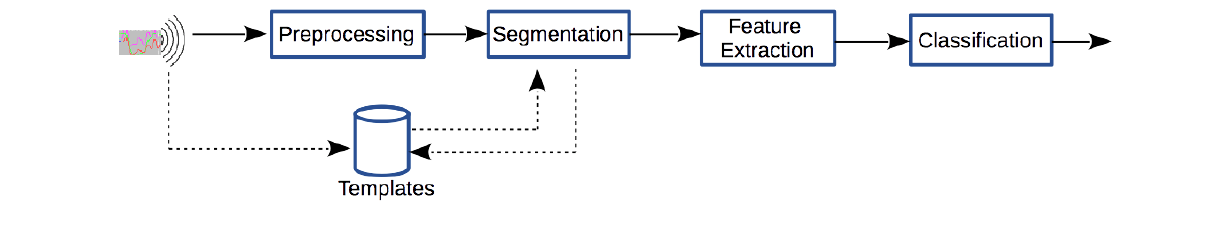
Figure 1. Steps involved in the development of an inertial measurement unit (IMU)-based exercise classification